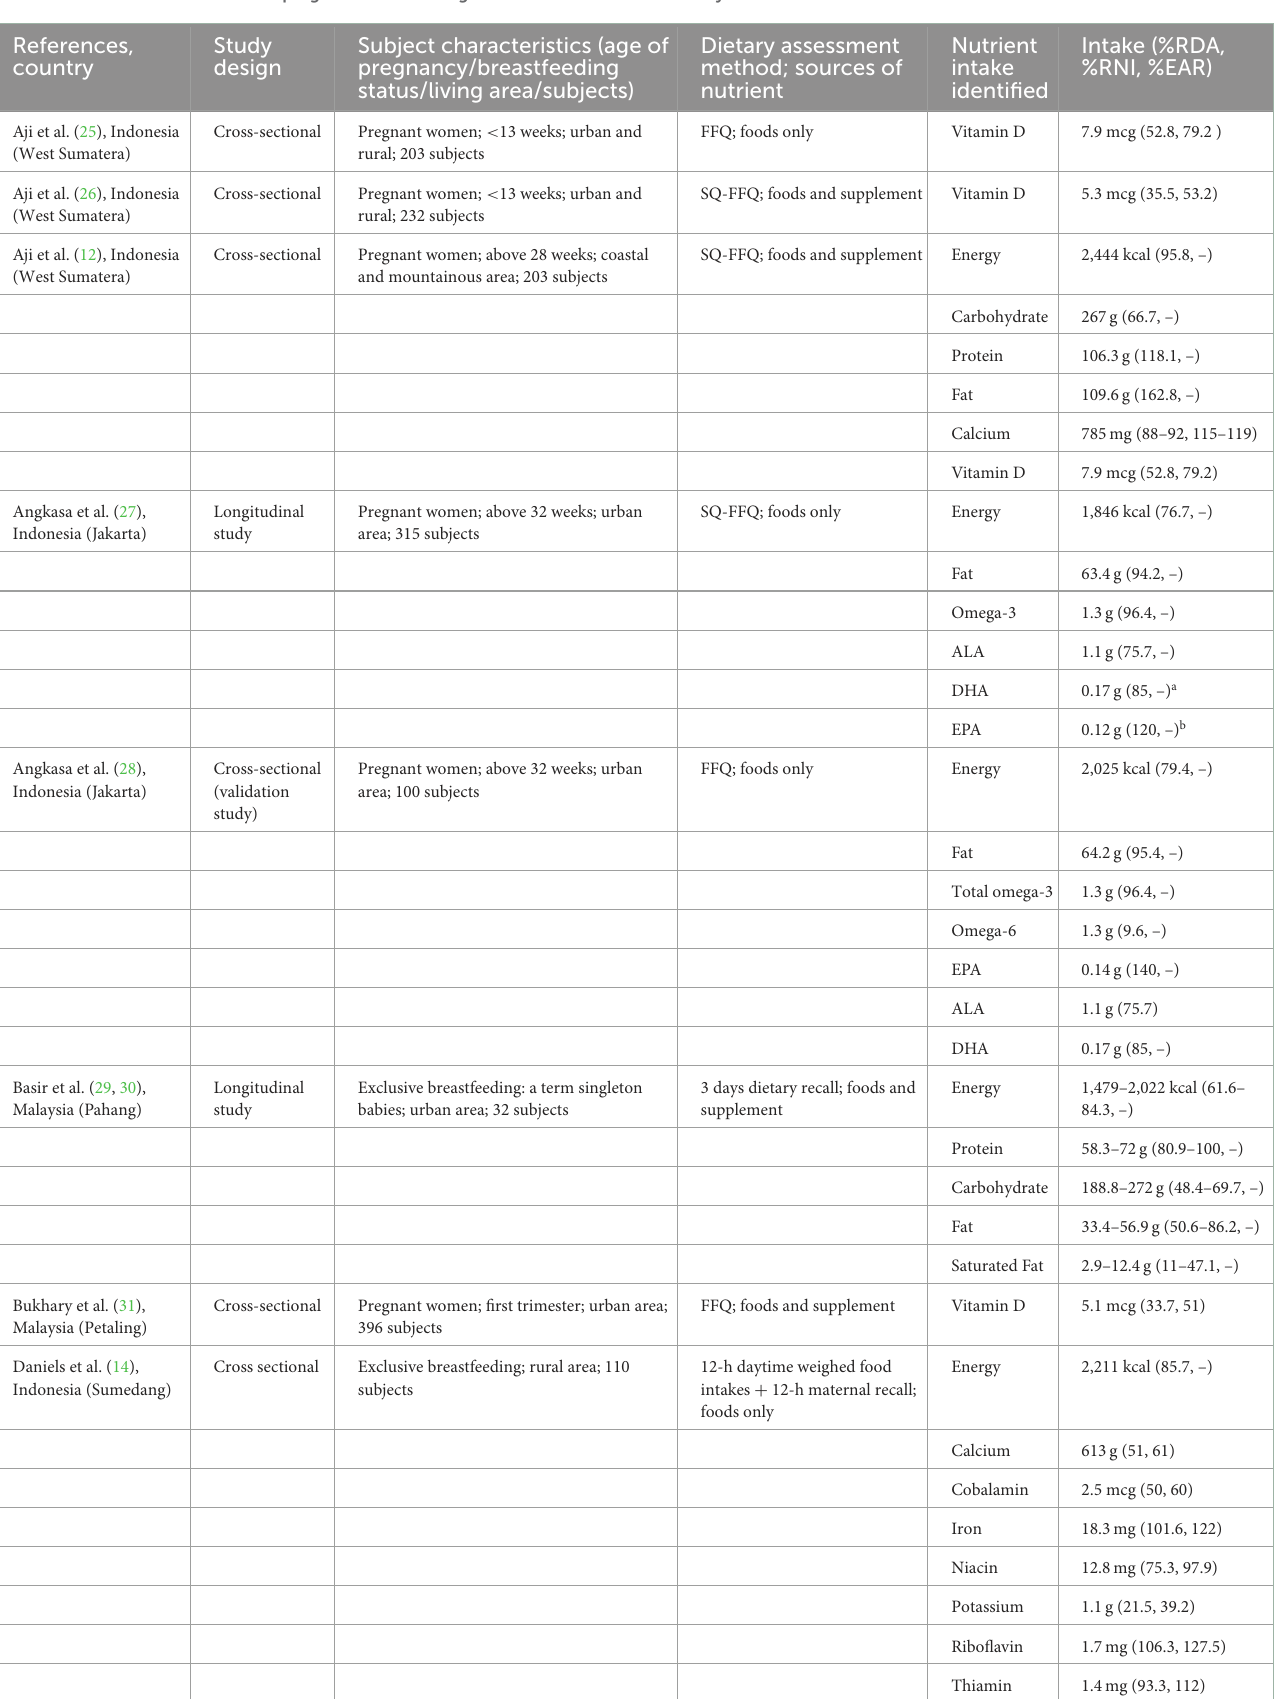
TABLE 1 Studies characteristics of pregnant and lactating women in Indonesia and